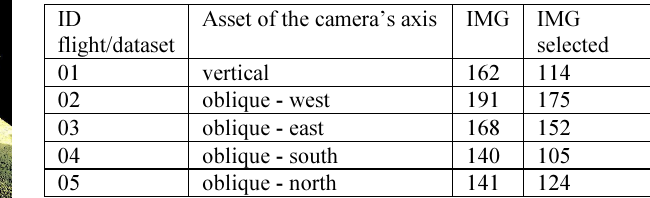
Table 2: Images used for data processing